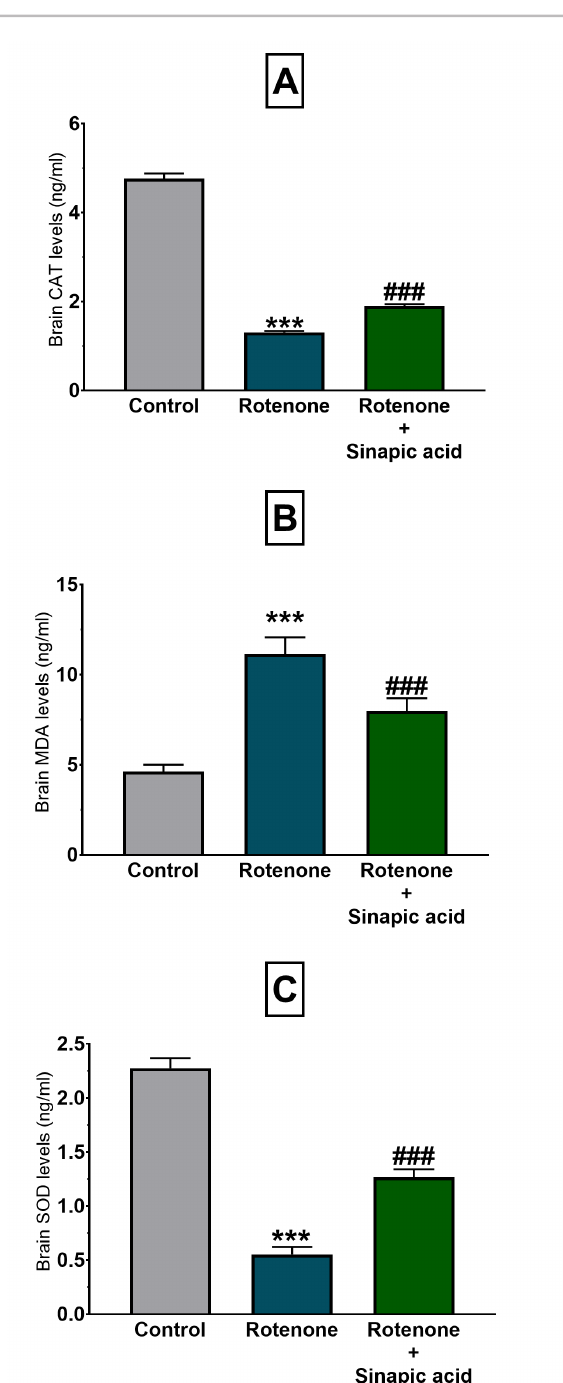
FIGURE S1 - Brain iron (A) and transferrin (B) levels after sinapic acid treatment and rotenone insult. In parallel with serum results sinapic acid significantly decreased rotenone- induced increase in iron and transferrin levels in the brain tissue. All data expressed as mean ± SD. ***p<0.001 versus control, ### p<0.001, # p<0.05versus rotenone